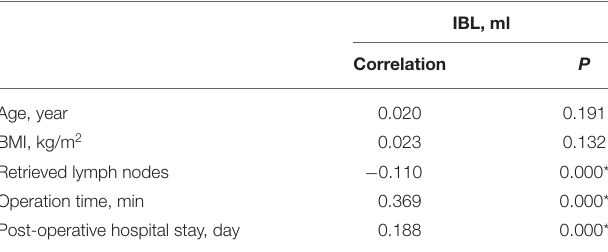
TABLE 4 | Correlation of IBL and clinical